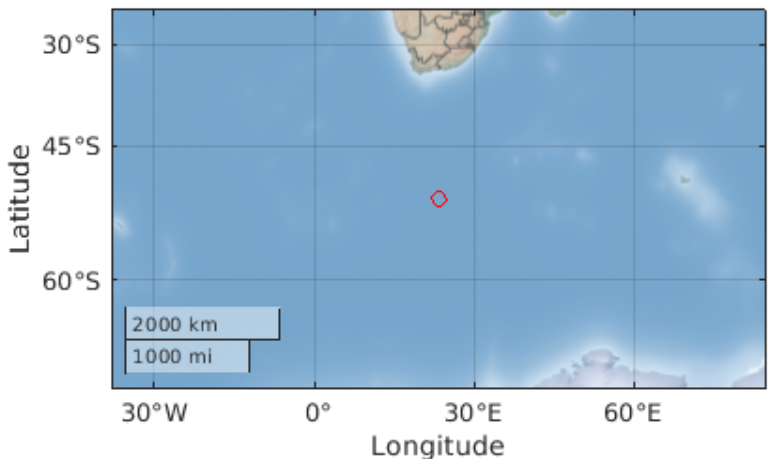
Figure 6. ISS location projected on Earth, just south of the tip of South Africa.